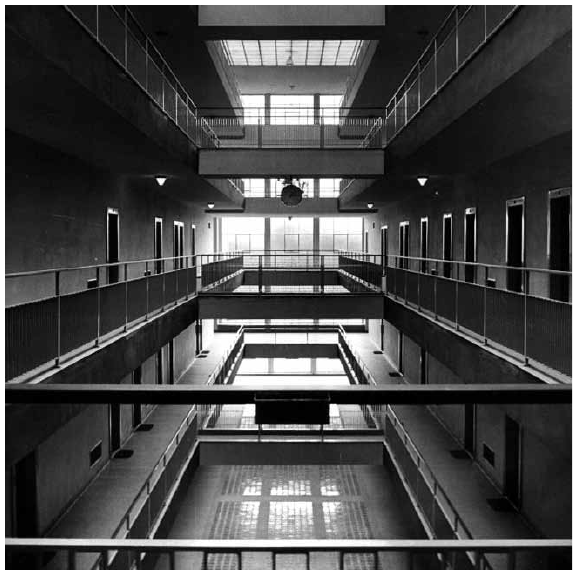
fig. 13. j. Gočár, Grandhotel in Pardubice,